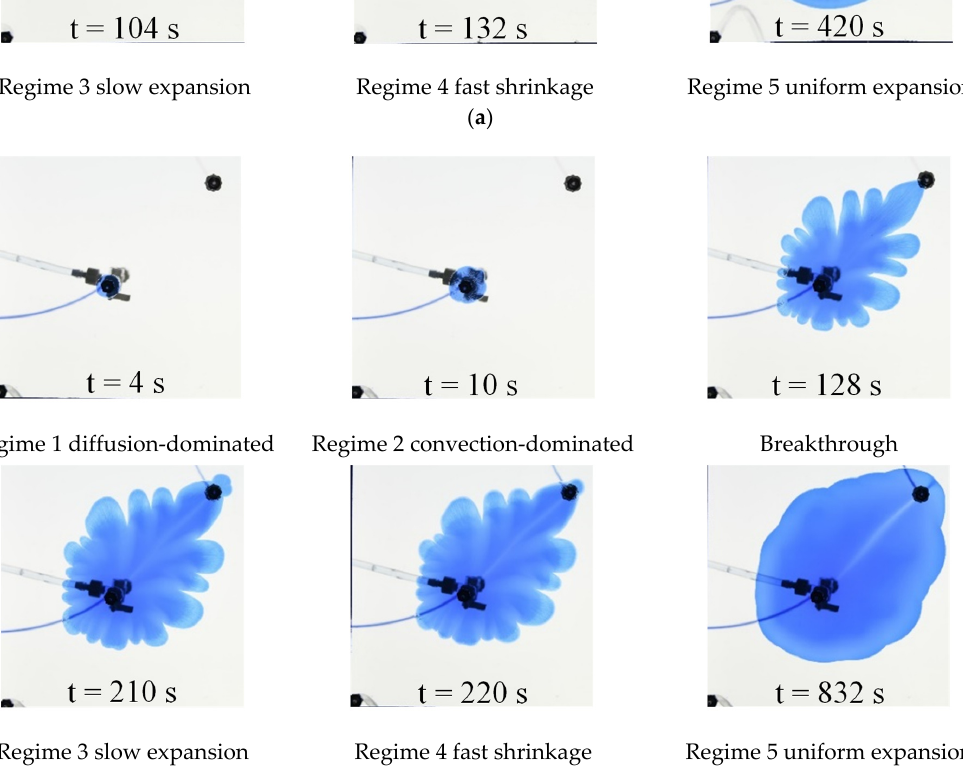
time, when the size of the water plume is much smaller for the two-pump scenario. This indicates that the constant extraction by the additional pump at the outlet may induce an extra pressure gradient from the injector to producer that is favorable for the injected water flowing to the production end. This also suppresses the expansion of the water plume in other directions. At the injection rate of 5.0 mL/min, this results in a much smaller water plume (i.e., 6641 mm 2 vs. 13,060 mm 2 ). At the injection rate of 2.0 mL/min, the water plume for the two-pump scenario is also much smaller. Both scenarios lead to a comparable size of water plume at the end of the fast shrinkage regime for an injection rate of 5.0 mL/min. At a small injection rate of 2.0 mL/min, the shrinkage regime for the two-pump scenario is however not noticeable. A much larger, stable water plume is ob- served as water is continuously injected during the following slow expansion regime for the two-pump scenario, as shown in Figure 10a at t = 132 s and Figure 10b at t = 220 s.